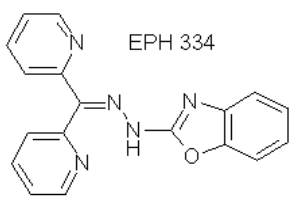
Figure 9. EPH334 chemical structure.